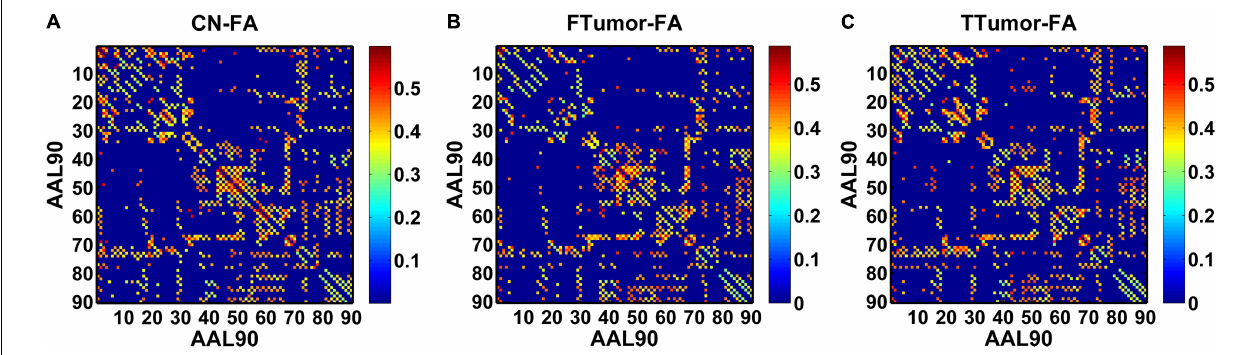
FIGURE 1 | A symmetric 90 × 90 matrix representing the mean FA-weighted structural network for all participants. (A) indicating the mean FA-weighted structural network for CN; (B) indicating the mean FA-weighted structural network for FTumors; (C) indicating the mean FA-weighted structural network for TTumors.